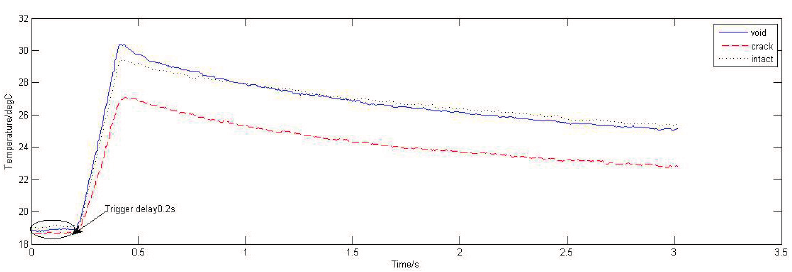
Figure 12. Temperature image at 0.4 s, where (1), (2) and (3) represent the crack solder ball, the intact solder ball and the void solder ball respectively.